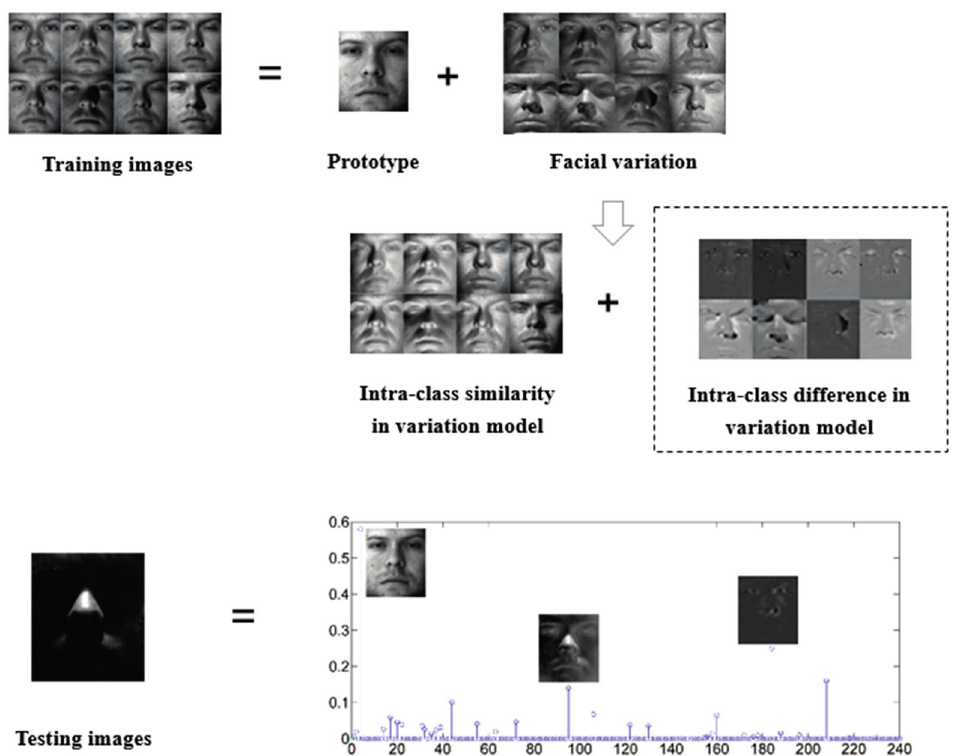
Figure 2. The basic idea of our method. ( Top ) The intra-class variant basis derived from the reference person can be shared by other people; ( Bottom ) The nonzero coefficients of the sparse representation are expected to concentrate on the training samples with the same identity as the test sample and on the related intra-class similarity and difference of facial variant